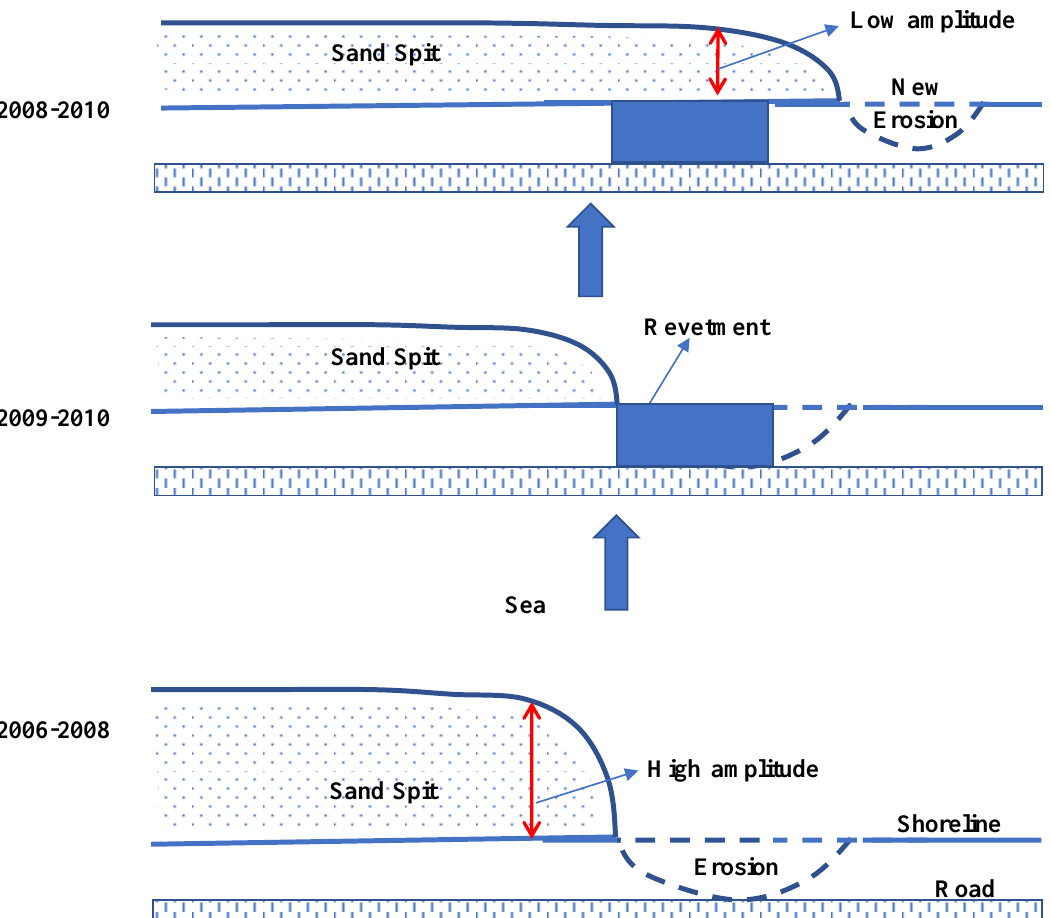
Figure 20. Schematic diagram of the recent morphological process around the sand spit.